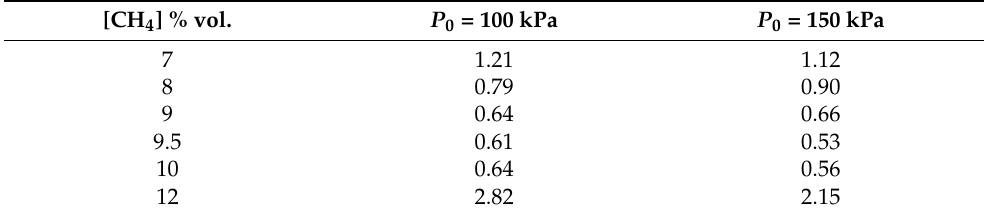
Table 2. Experimentally determined minimum ignition energies in the explosion cell with a volume of 0.17 L, with Φ /h = 1, by varying the initial pressure and the concentration of CH 4 . [CH 4 ] % vol.